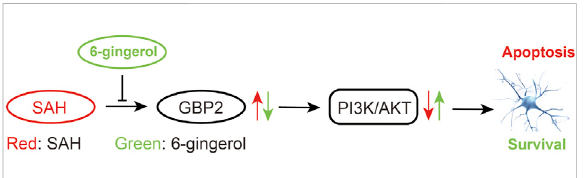
FIGURE 8 A Schematic representation of signaling pathways showing that 6-gingerol alleviates neuronal apoptosis. GBP2 was up- regulated in SAH, which may promote SAH-induced neuronal apoptosis via inhibition of the PI3K/AKT pathway. However, 6-gingerol can inhibit GBP2-mediated neuronal apoptosis by reactivating the PI3K/AKT signaling